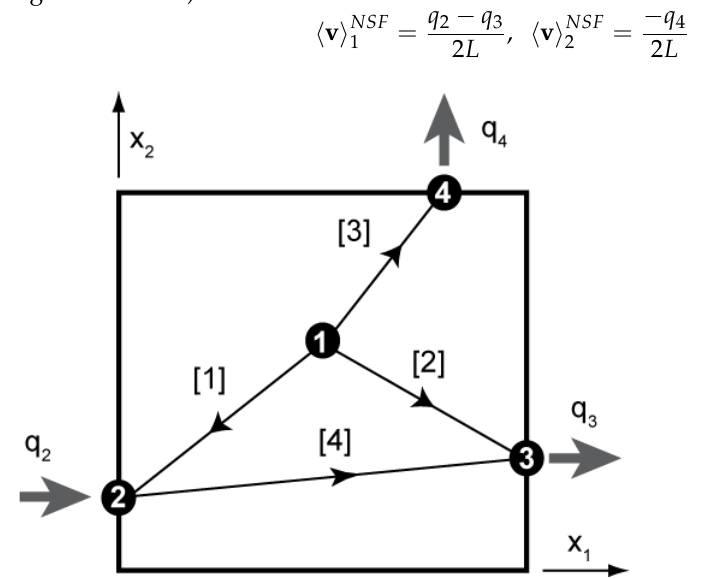
Figure 9. Schematic illustration of the NSF criterion on a simple fracture network. Note that only the normal fluxes perpendicular to the faces of the block are available at the nodes that are located on the boundary (compare to the VSF method of Figure 10).